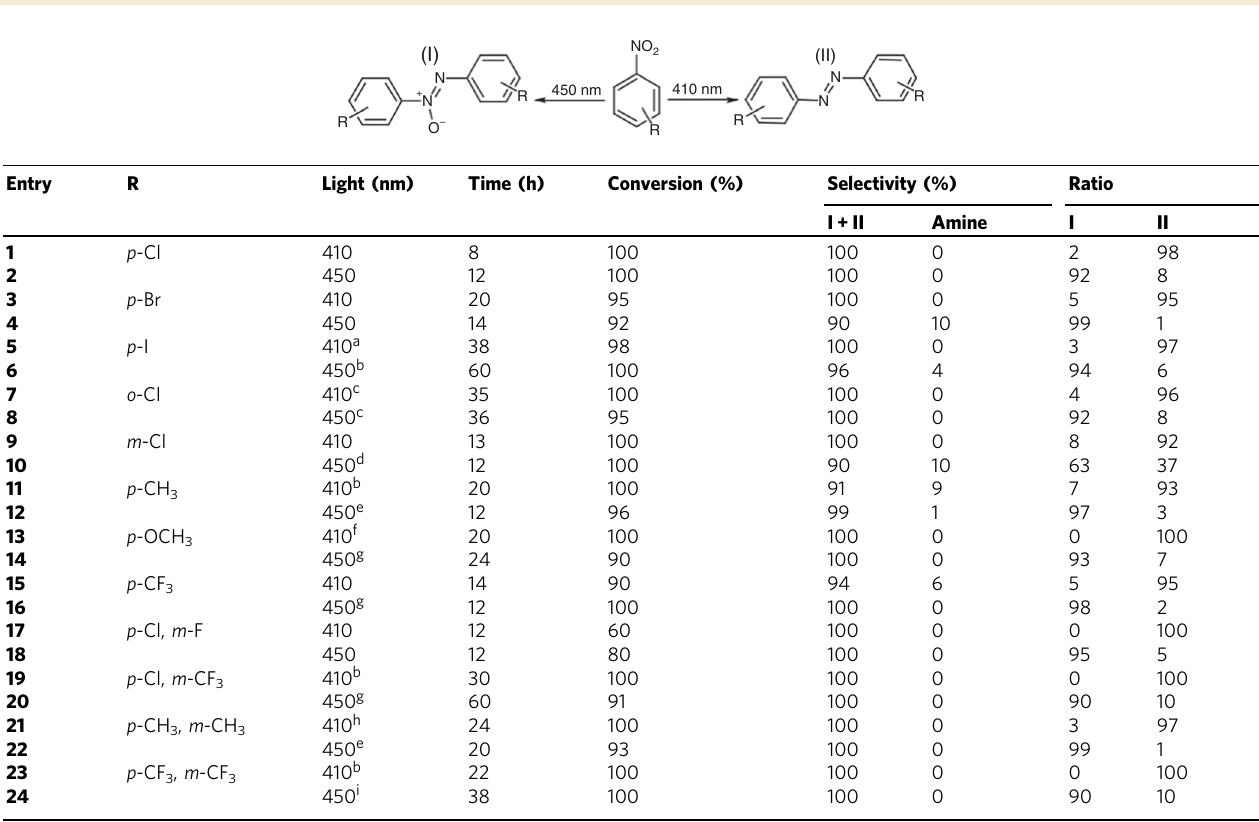
Table 2 Photocatalytic reduction of various nitroaromatic compounds to azoxy- (I) and azo- (II) aromatic compounds using the g-C 3 N 4